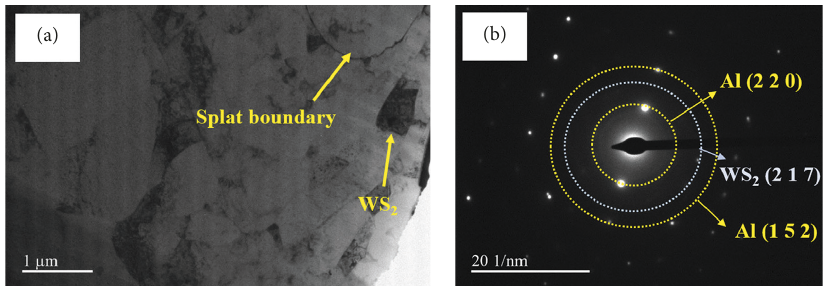
Figure 16: TEM imaging of WS 2 -Al MMC coating: (a) bright field imaging with multiple splats, subgrains, and (b) SAED pattern [78].